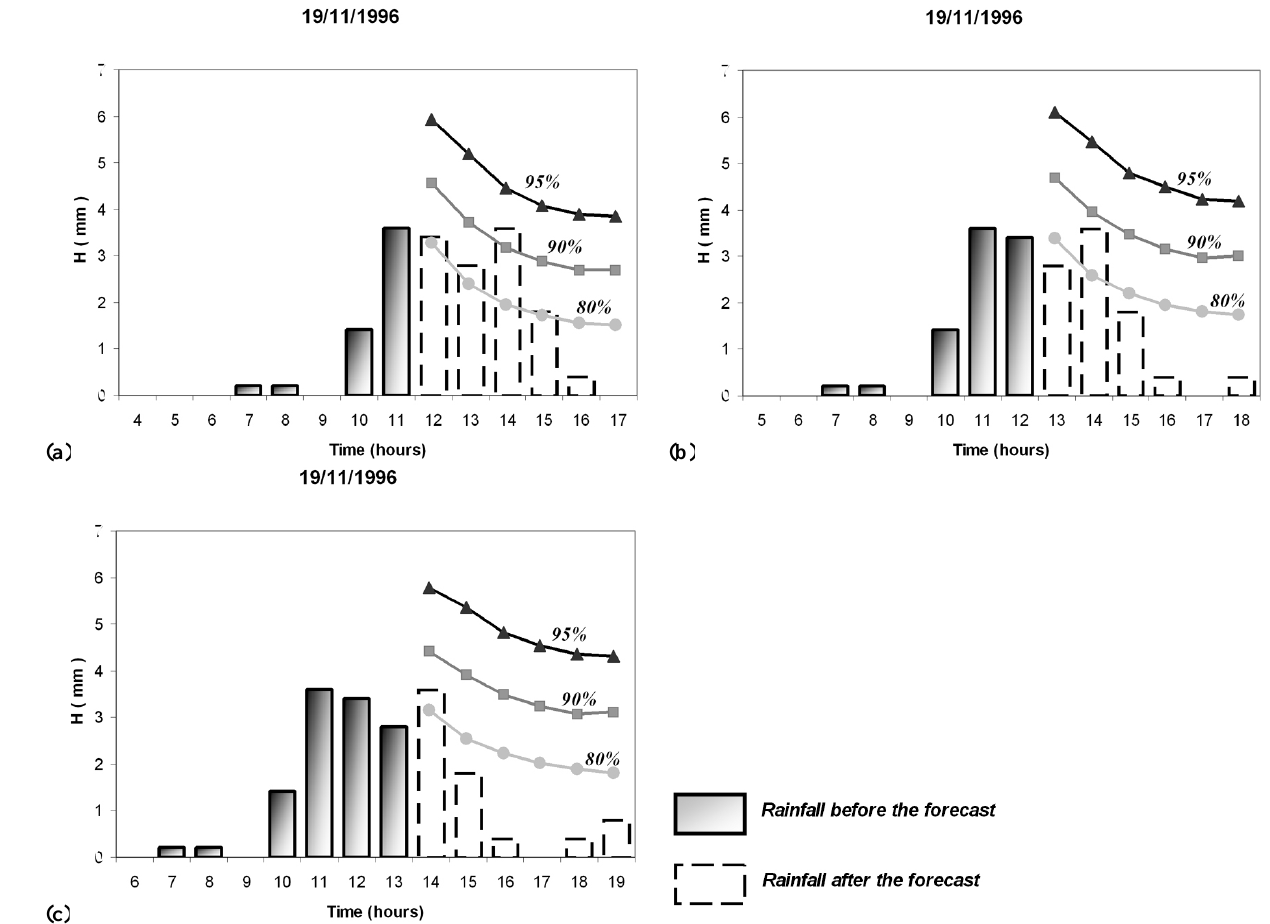
Fig. 7. Application of PRAISE Model relative to 19 November 1996, for the Cosenza raingauge, starting from (a) 11:00 LT; (b) 12:00 LT; (c) 13:00 LT. Table 4. Cosenza raingauge: estimated parameters of the densities f (